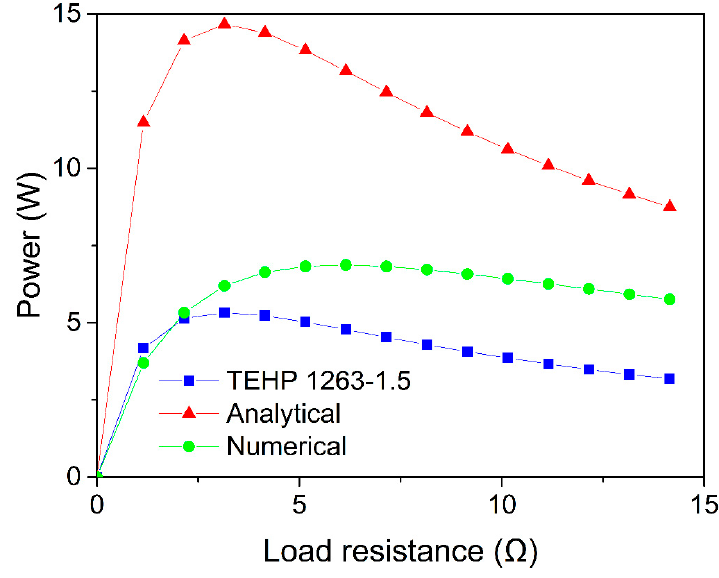
Figure 6. Power as a function of applied load with T c = 30 °C and T h = 300 °C.